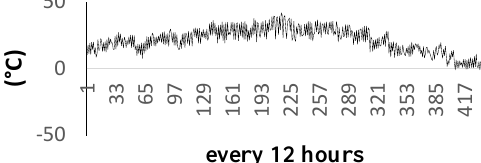
Figure 10 .Relative Humidity for every 12 ℎ in 2013